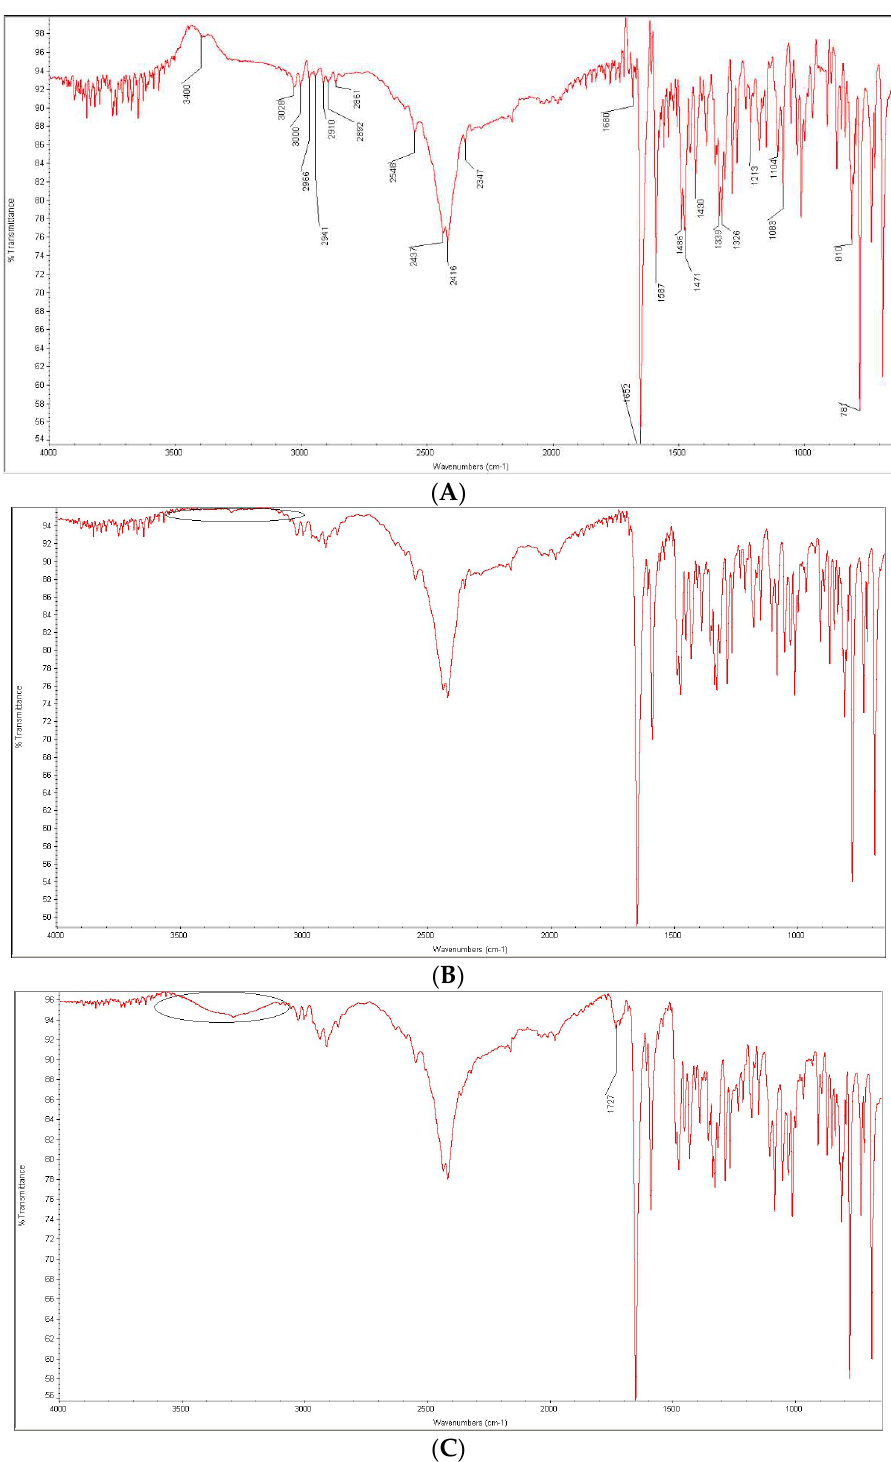
Figure 14. FT-IR spectra of azelastine (AZE) as a bulk ( A ) and in the mixtures with polyvinyl alcohol (PVA): non-stressed mixture ( B ) and the mixture stressed under UV/VIS light ( C